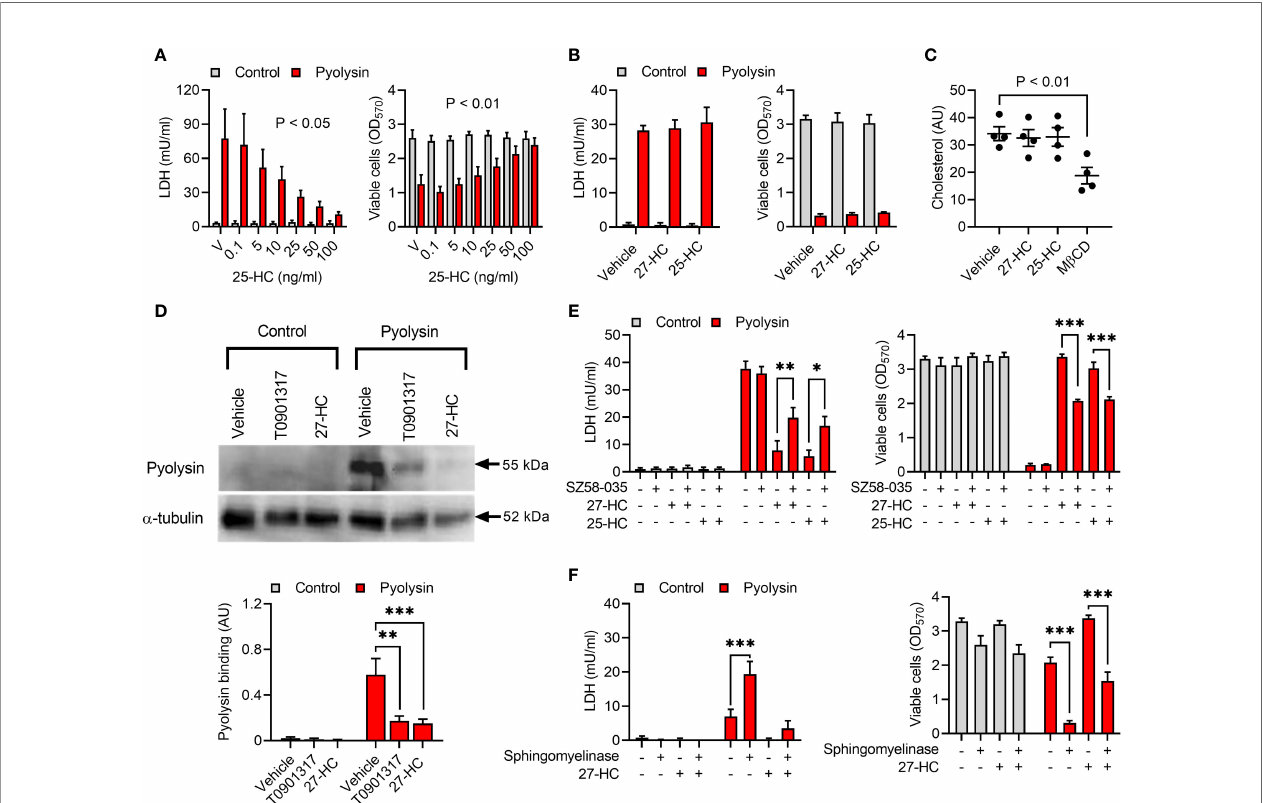
FIGURE 7 | Oxysterols reduce accessible cholesterol. (A) HeLa cells were cultured for 24 h in medium containing 10% serum with vehicle (V) or the indicated concentrations of 25-hydroxycholesterol (25-HC), and then challenged for 2 h with control serum-free medium ( ■ ) or 100 HU pyolysin ( ■ ). The leakage of LDH was measured in cell supernatants and viable cells were determined by MTT assay. Data are presented as mean + s.e.m. from 4 independent experiments; statistical signi fi cance was determined by ANOVA, and P values reported for the treatment effect on pyolysin challenge. (B) HeLa cells were challenged for 2 h with control serum-free medium ( ■ ) or 100 HU pyolysin ( ■ ) mixed with vehicle, 10 ng/ml 27-hydroxycholesterol (27-HC), or 10 ng/ml 25-HC. The leakage of LDH was measured in cell supernatants and viable cells were determined by MTT assay. Data are presented as mean + s.e.m. from 4 independent experiments. (C) HeLa cells were cultured for 24 h in serum-free medium with vehicle, 10 ng/ml 27-HC, 10 ng/ml 25-HC or 1 mM methyl- b -cyclodextrin (M b CD). Total cellular cholesterol was quanti fi ed and normalized to total protein. Data are presented as mean ± s.e.m. with dots representing the values from 4 independent experiments; statistical signi fi cance was determined by ANOVA with Dunnett ’ s post hoc test. (D) Representative Western blots of pyolysin binding and a -tubulin are shown for HeLa cells cultured for 24 h in serum-free medium with vehicle, 10 ng/ml 27-HC, or 50 nM T0901317 as a positive control. Densitometry data for pyolysin binding were normalized to the a -tubulin loading control and presented as mean + s.e.m. from 4 independent experiments; statistical signi fi cance was determined by ANOVA with Tukey ’ s post hoc test, ***P < 0.001, **P < 0.01. (E) HeLa cells were cultured for 16 h in serum-free medium with vehicle or 10 µM SZ58-035, washed twice with PBS, cultured for 24 h in control serum-free medium with vehicle, 10 ng/ml 27-HC or 10 ng/ml 25-HC, in combination with vehicle or 10 µM SZ58-035; and then challenged for 2 h with control serum-free medium ( ■ ) or 100 HU pyolysin ( ■ ). The leakage of LDH was measured in cell supernatants and viable cells were determined by MTT assay. Data are presented as mean + s.e.m. from 4 independent experiments; statistical signi fi cance was determined by ANOVA and Tukey ’ s post hoc test, ***P < 0.001, **P < 0.01, *P < 0.05. (F) HeLa cells were cultured for 24 h in serum-free medium with vehicle or 10 ng/ml 27-HC, treated for 30 min in serum-free medium with or without 100 mU/ml sphingomyelinase, and then challenged for 2 h with control serum-free medium ( ■ ) or 25 HU pyolysin ( ■ ). The leakage of LDH was measured in cell supernatants and viable cells were determined by MTT assay. Data are presented as mean + s.e.m. from 4 independent experiments; statistical signi fi cance was determined by ANOVA and Tukey ’ s post hoc test, ***P <